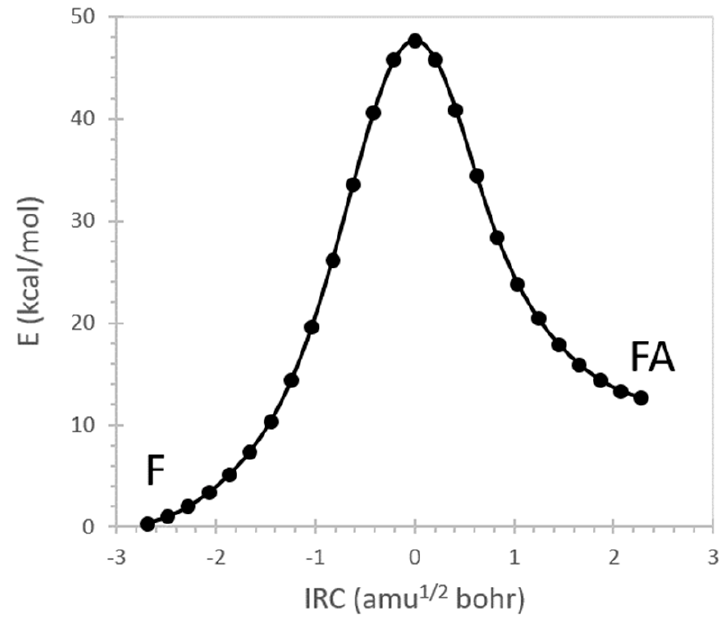
Figure 4. B3LYP/aVTZ energy profile for the tautomerization of formamide (F) to formimidic acid (FA). IRC = 0 corresponds to the transition state.